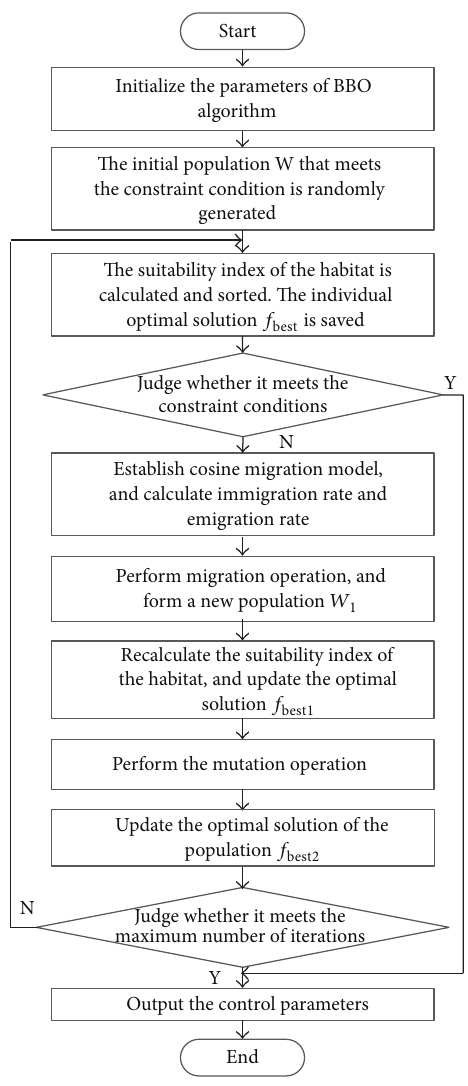
Figure 3: Flow chart of SSDC parameter optimization based on IBBO